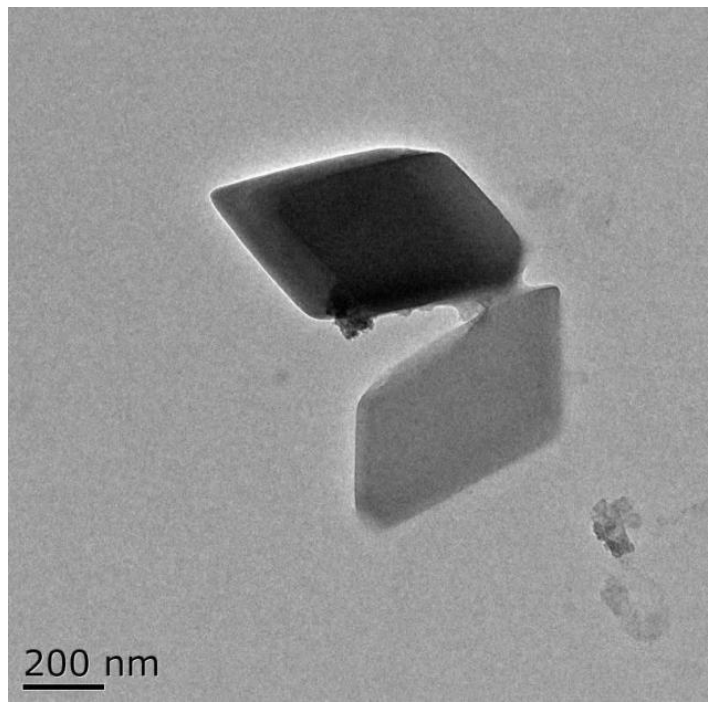
Figure 1. TEM images of SAMs. Scale bars correspond to 200 nm.